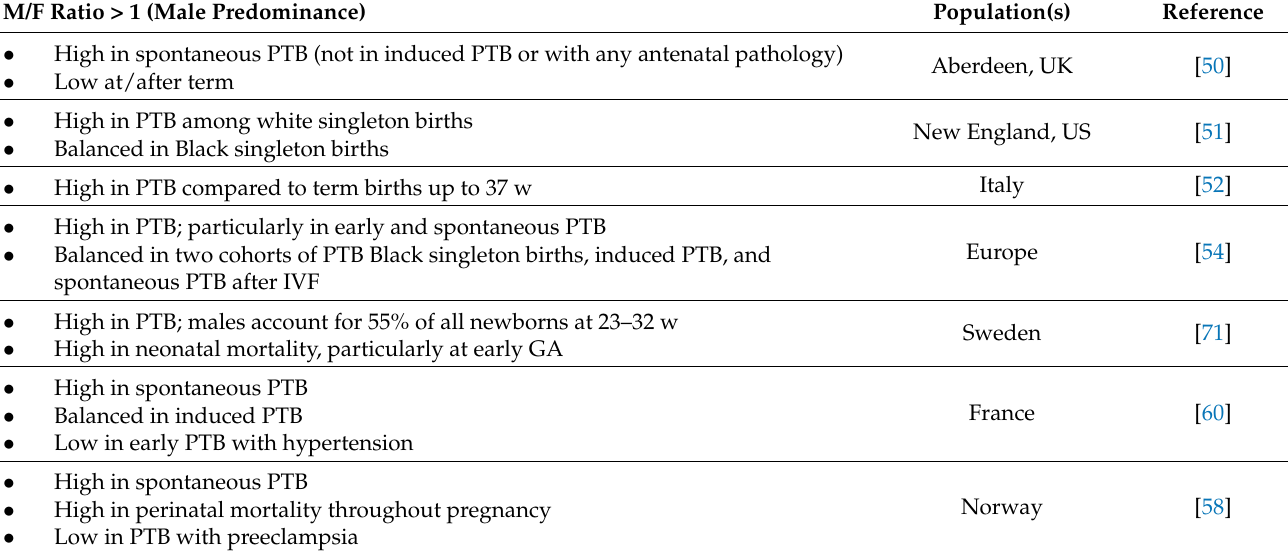
Table 1. Summary of findings from preterm birth (PTB) studies. An asterisk (*) indicates n PTB < 1000. M/F Ratio > 1 (Male